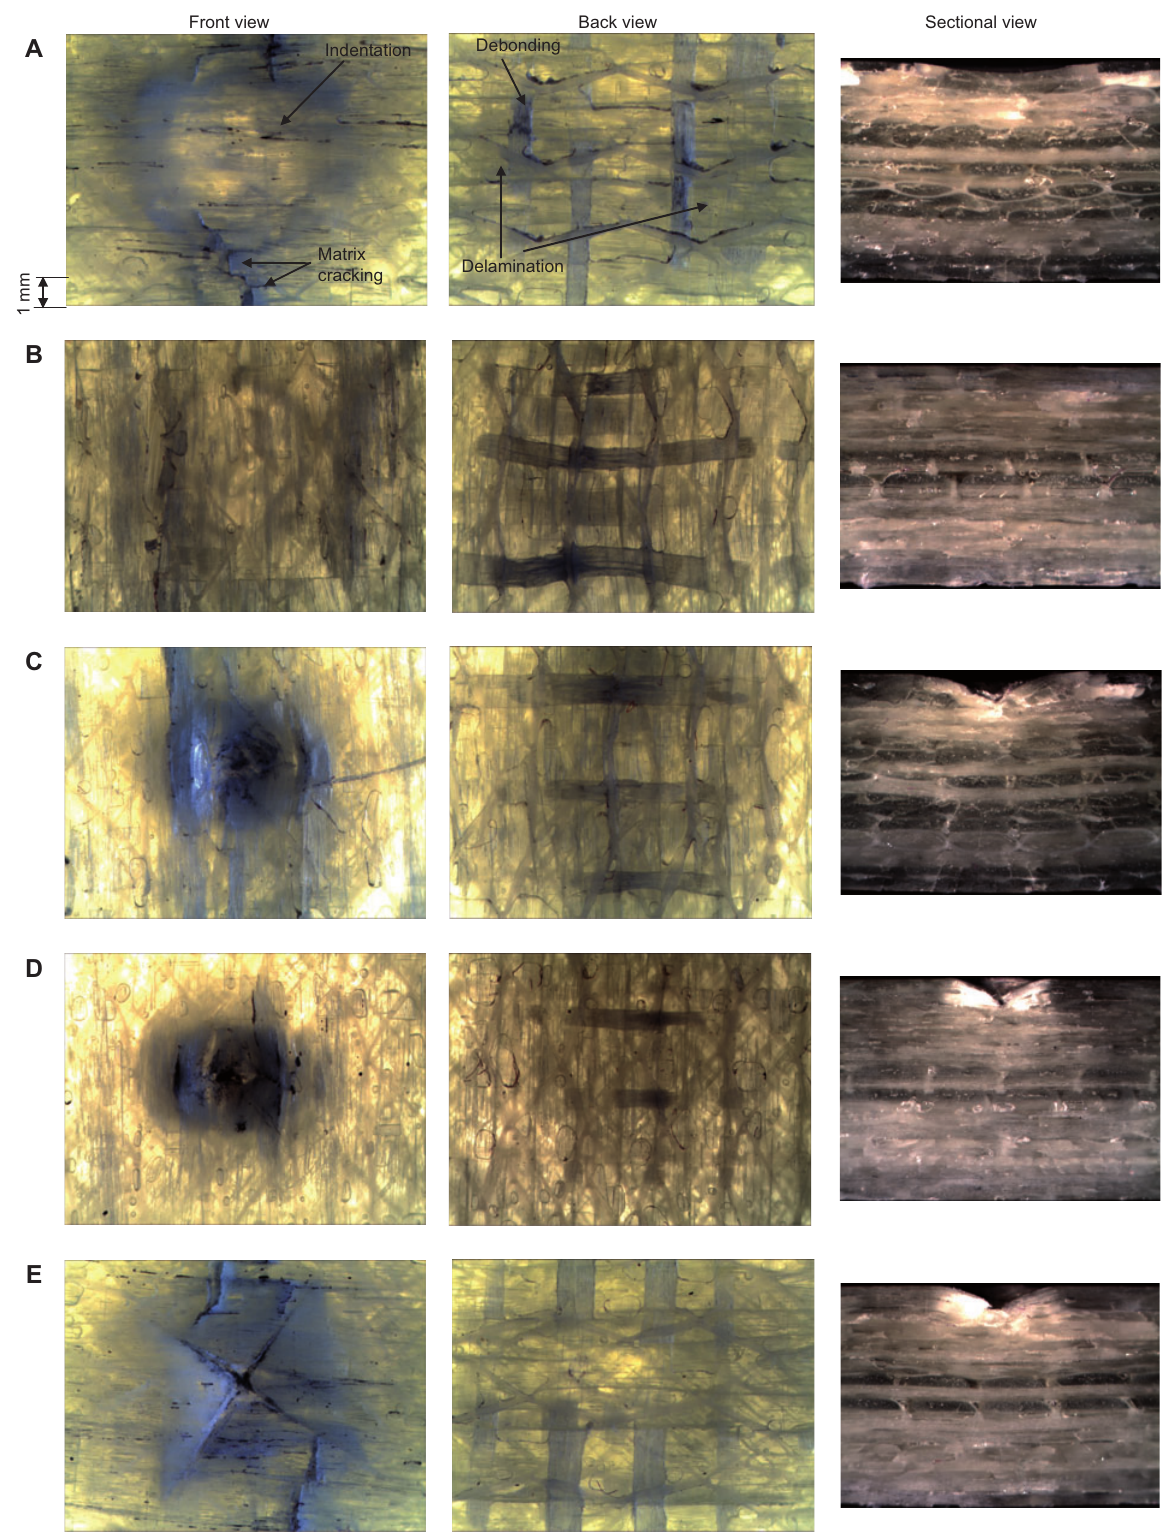
Figure 10 Front, back and sectional views of damaged zone caused by (A) 12 mm hemispherical tap, (B) 24 mm hemispherical tap, (C) 90 ° conical tap, (D) 120 ° conical tap and (E) pyramidal